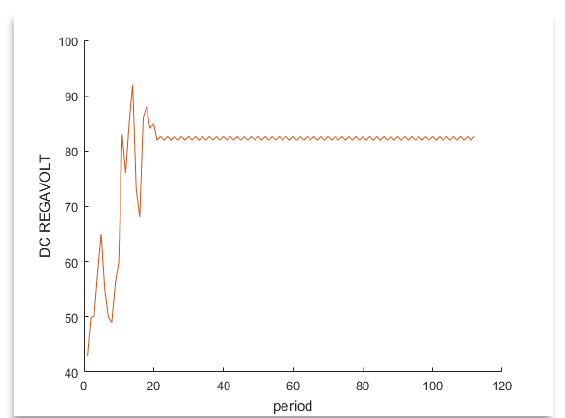
Figure 9. Regavolt chart for 20 time periods for the Nazarabad line.